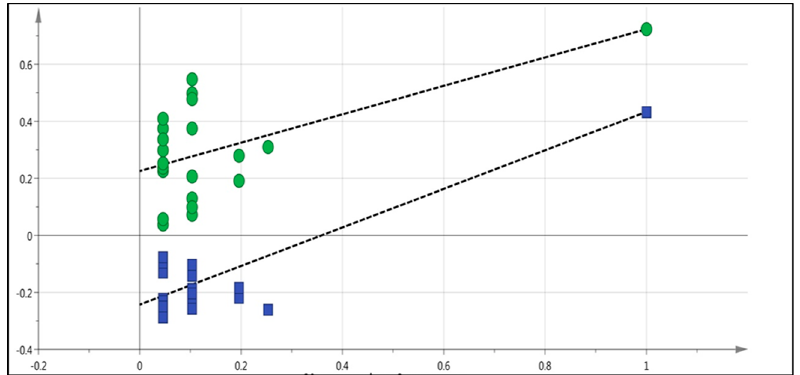
Figure 9. Permutation results of Partial Least Square ‐ Discriminant Analysis (PLS ‐ DA).